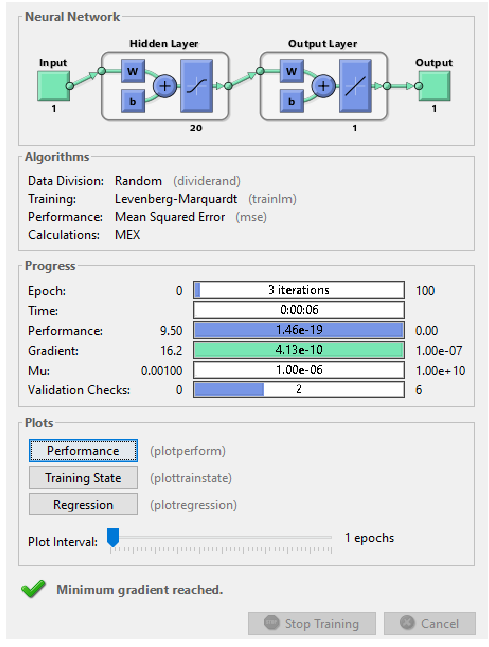
Figure 9. Trained ANN.